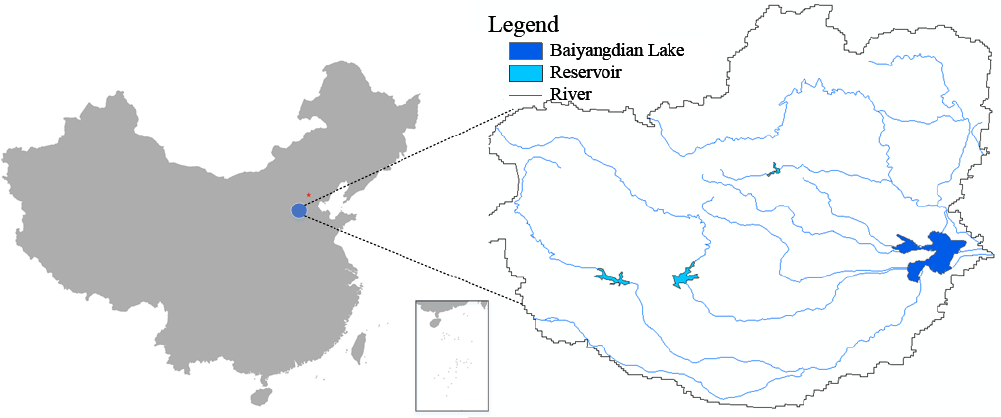
Figure 1. Location of the Baiyangdian Lake, North China.